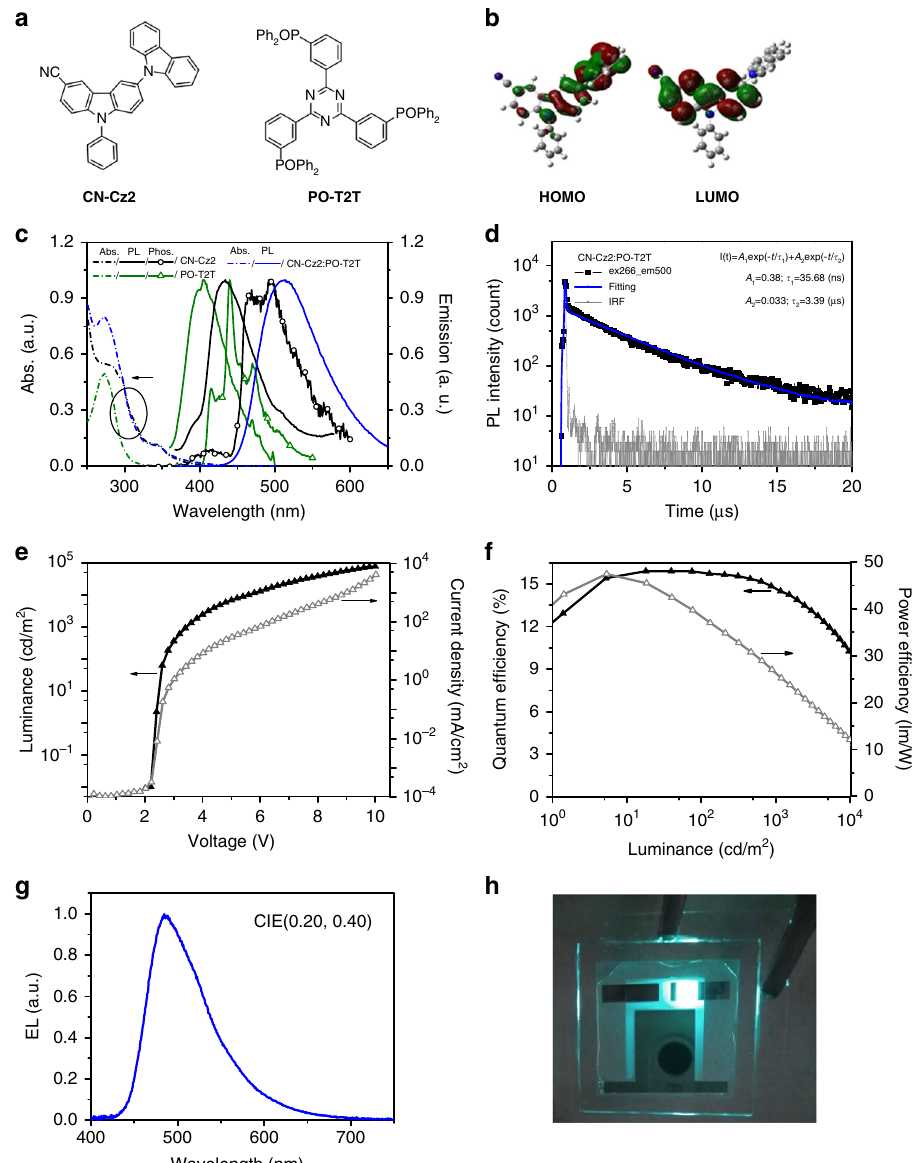
Fig. 1 Photophysical properties of CN-Cz2, PO-T2T, and the exciplex CN-Cz2:PO-T2T (1:1). a Chemical structures of CN-Cz2 and PO-T2T. b Highest occupied molecular orbital (HOMO) and lowest unoccupied molecular orbital (LUMO) of CN-Cz2 according to DFT calculations at the B3LYP/6-31G(d) level. c Normalized photoluminescence (PL) and absorption spectra of CN-Cz2, PO-T2T as well as their blend fi lm in the ratio 1:1. d Transient PL decay properties of CN-Cz2:PO-T2T (1:1) blend fi lm at 300 K. The performance of OLEDs using CN-Cz2:PO-T2T (1:1) blend fi lm as the emitter. e J – V – L characteristics. f EQE – PE – L characteristics. g EL spectrum of the CN-Cz2:PO-T2T (1:1) exciplex-based OLED. h A prototype demonstration of CN-Cz2:PO- T2T (1:1) exciplex OLED lighting